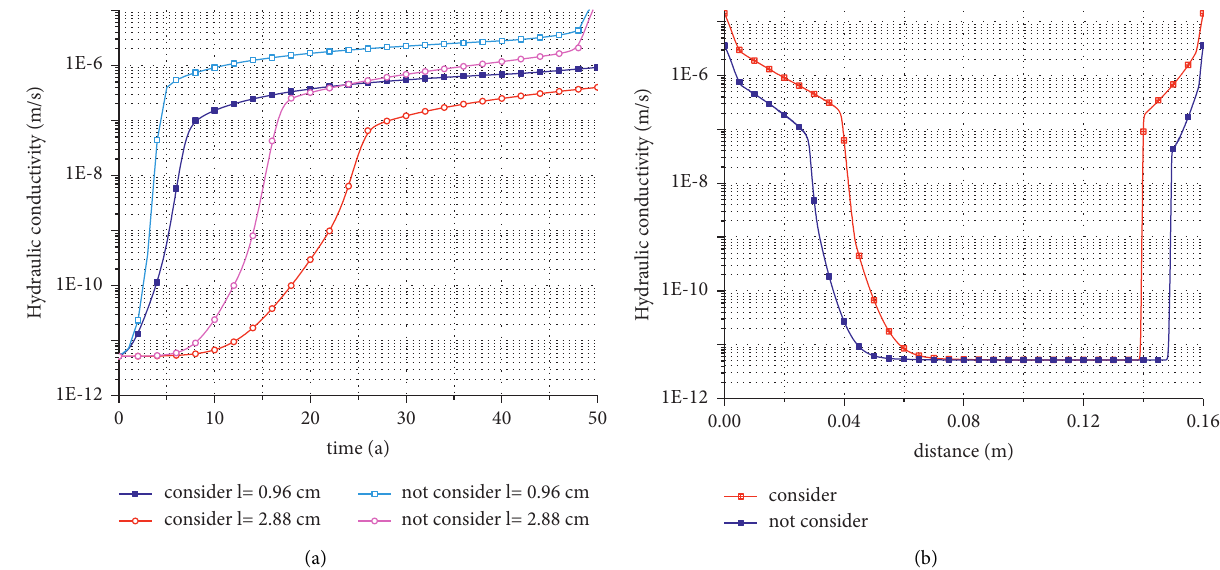
Figure 8: Time history of hydraulic conductivity and its space distributions at different time stations, obtained from simulations of considered different calcium compounds decomposition effect (solid dot) or not (empty dot). (a) Time history. (b) Space